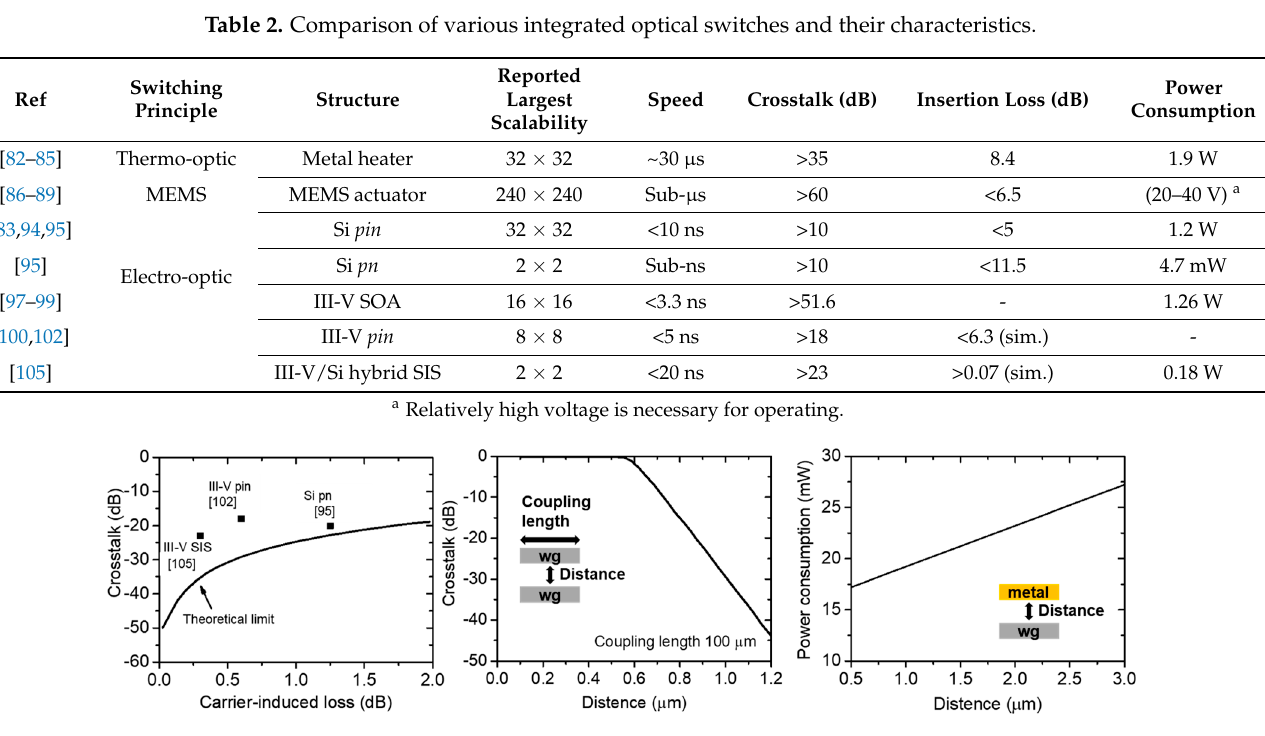
Figure 9. Main trade-off relationships of an optical switch using ( a ) carrier plasma dispersion effect, ( b ) MEMS actuator, and ( c ) thermo-optic